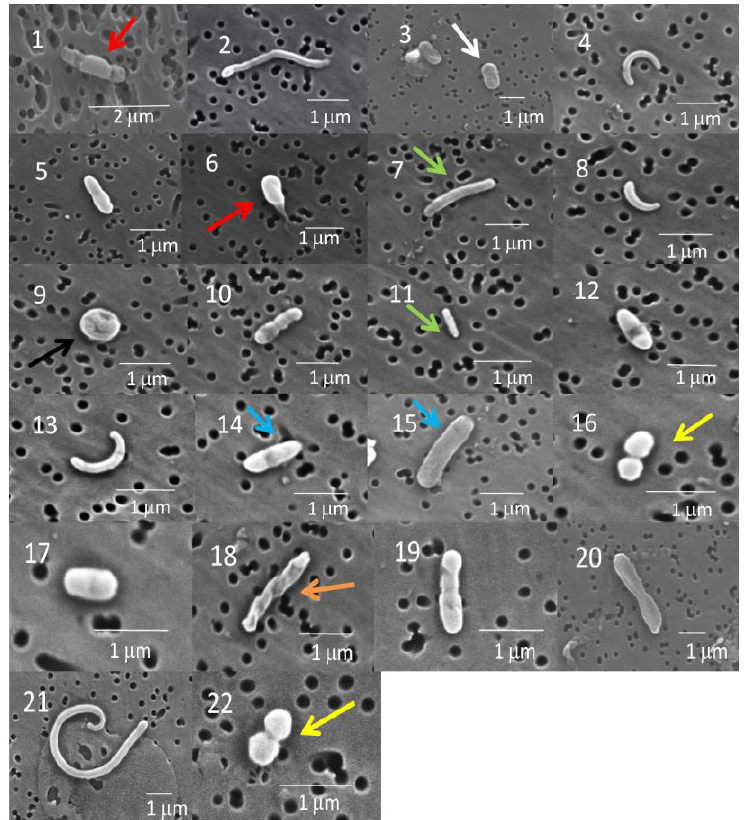
Figure 2. Scanning electron micrographs (SEM) of bacteria from the GISP2D ice core sections (panels 1 (cid:177) 6, 1,601 m; 7 (cid:177) 11, 2,501 m; 12 (cid:177) 18, 2,777 m; 19 (cid:177) 22, 3,014 m).